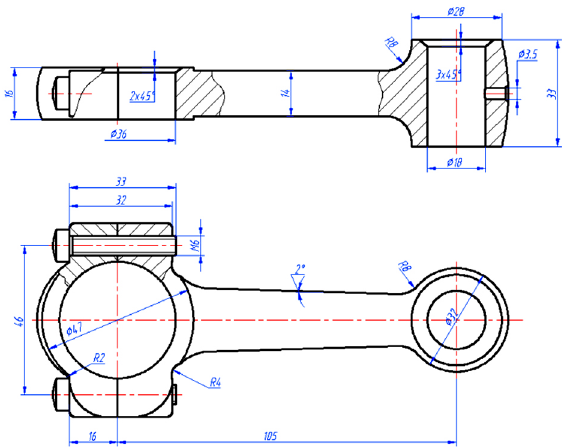
Fig. 3. Design of assembled connecting rod b)a)